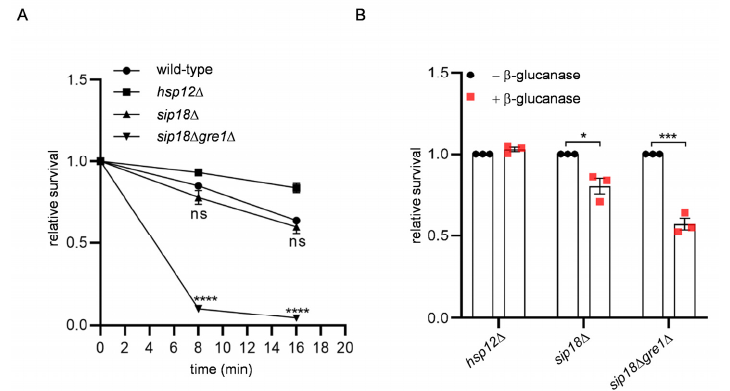
Figure 6. Stress sensitivity of hydrophilin mutant spores. ( A ) The indicated spores incubated with ether solution for the indicated times were plated on rich media, and colony numbers were counted. For each assay, the number of colonies obtained at 0 min (without ether treatment) were determined as 1, and the relative viability is shown. ( B ) The indicated spores treated with or without β -glucanase for 2 h at 37 °C were plated on rich media, and colony numbers were counted. Data are presented as the mean ± SEM. Statistical significance was determined by two-tailed unpaired Student’s t -tests. n = 3. *, p < 0.05; ***, p < 0.001; ****, p < 0.0001; ns, not significant ( p ≥ 0.05).